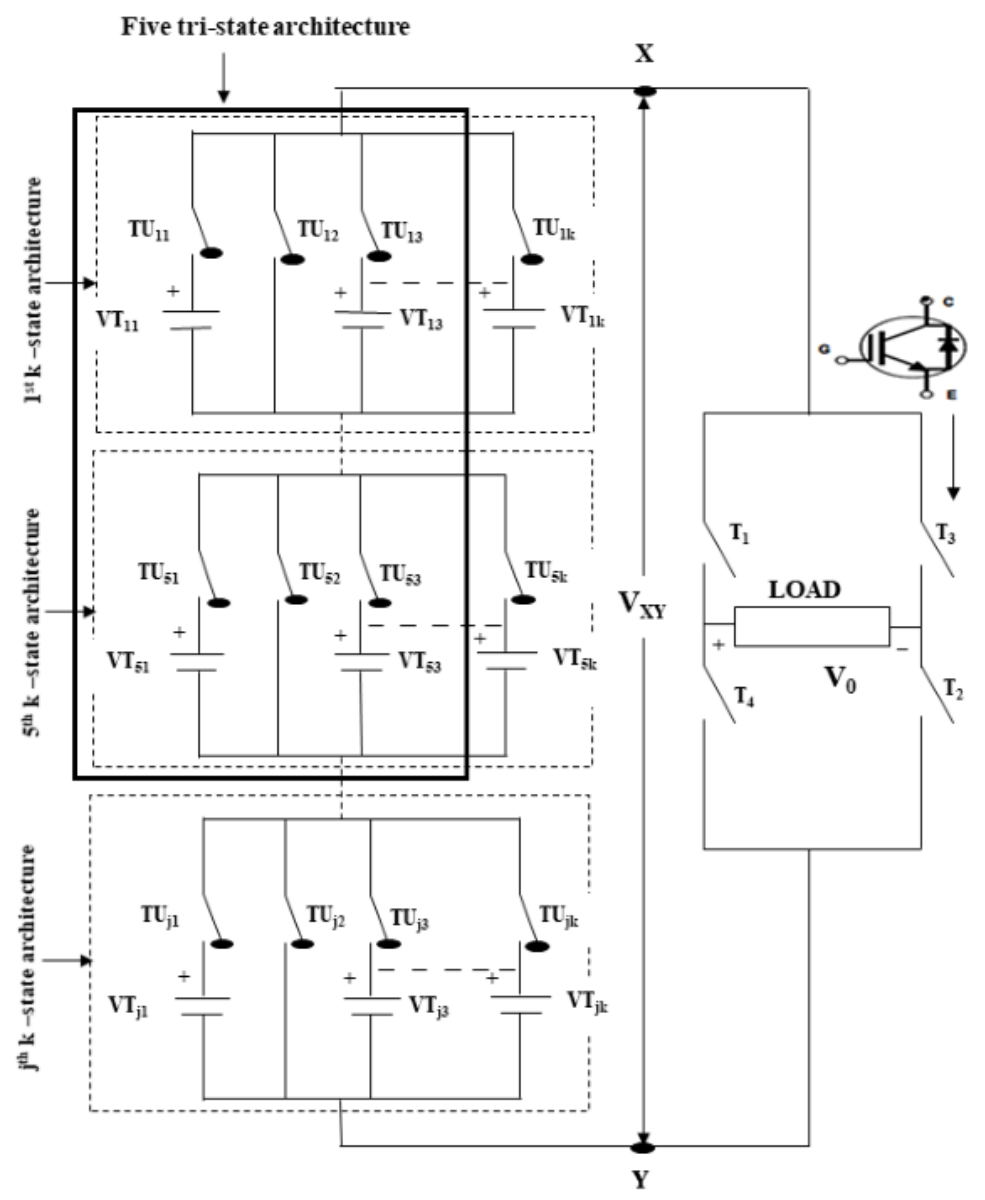
Figure 2. Realizing 485 level tri-state inverter from a k-state inverter.